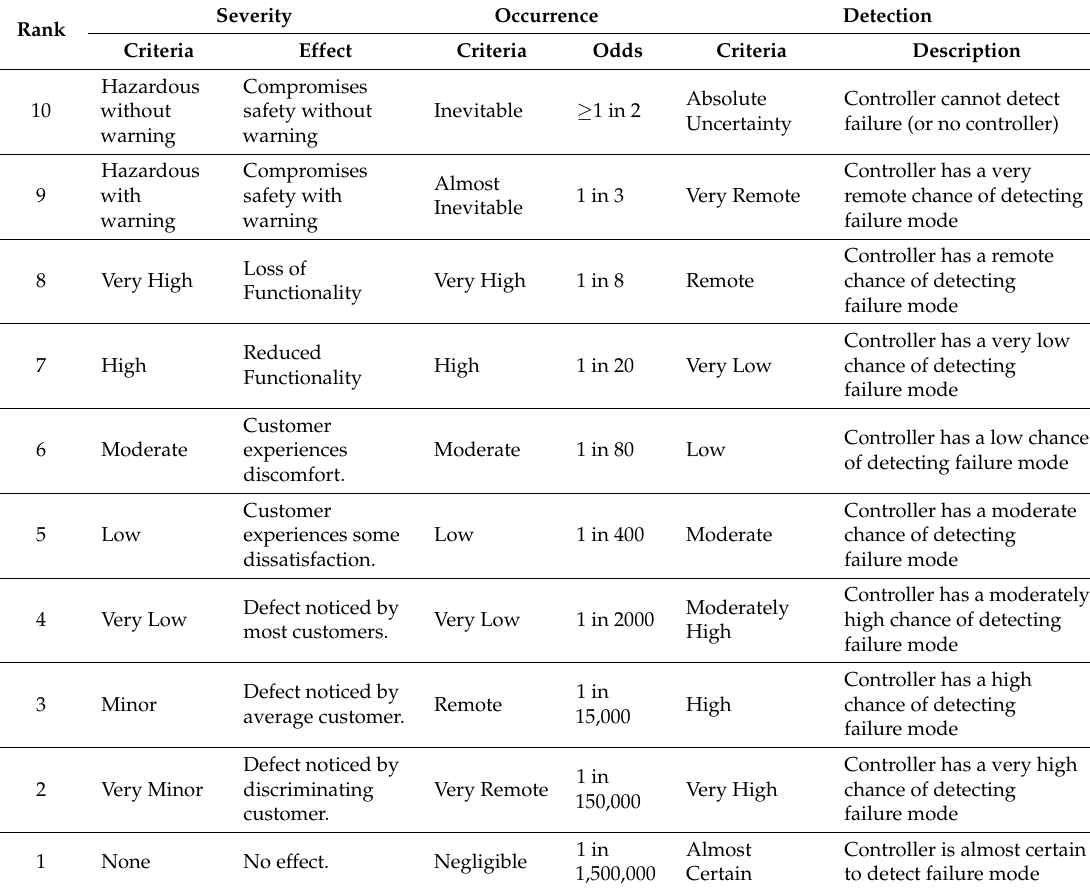
Table 4. Criteria Ranking for RPN